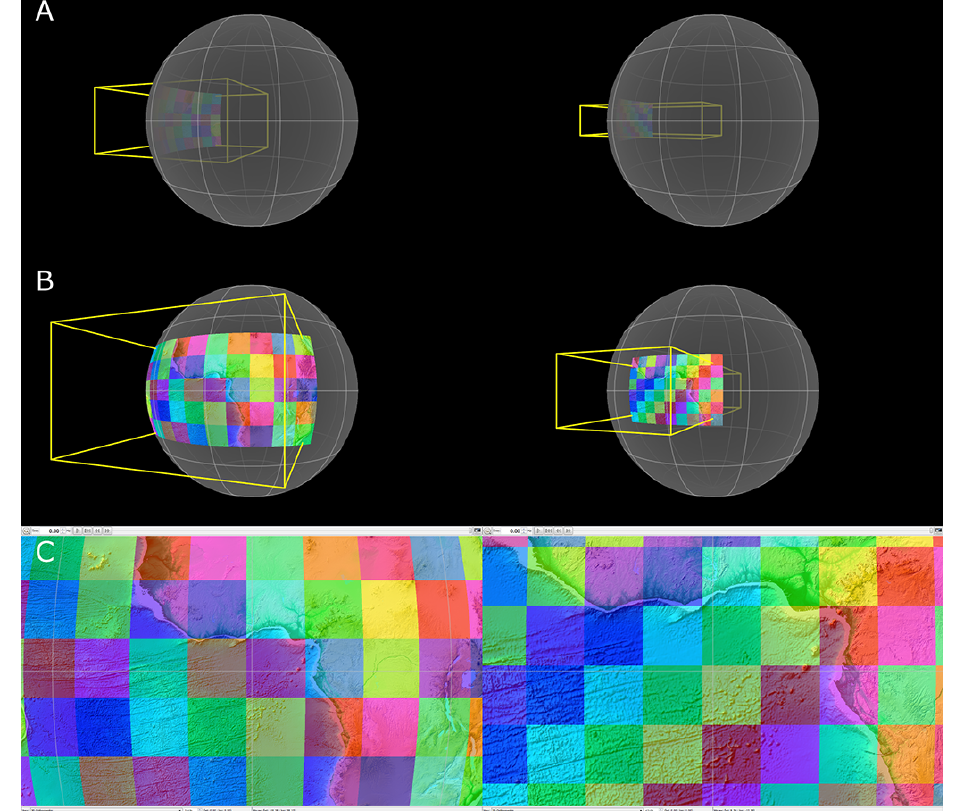
Figure 1. Visible geo-referenced tiles of the ETOPO1 (1 Arc-Minute Global Relief Model) raster (Amante and Eakins, 2009) highlighted with solid colours. The left and right sides show two different zoom levels. The yellow wireframe is the orthographic-(rectangular prism) view frustum used by the “3-D Orthographic” view in GPlates. Note that (A–B) on left side show the same zoomed-out view (yellow frustum) but from different angles – similarly for (A–B) on the right with the zoomed-in view. (A) more clearly shows that the yellow frustum contains only the front surface of the globe, rejecting the rear surface; (B) more clearly shows which geo-referenced tiles overlap the view frustum (yellow frustum) – note that tiles outside the frustum are culled; (C) The view as seen by the user of GPlates (the region inside the yellow